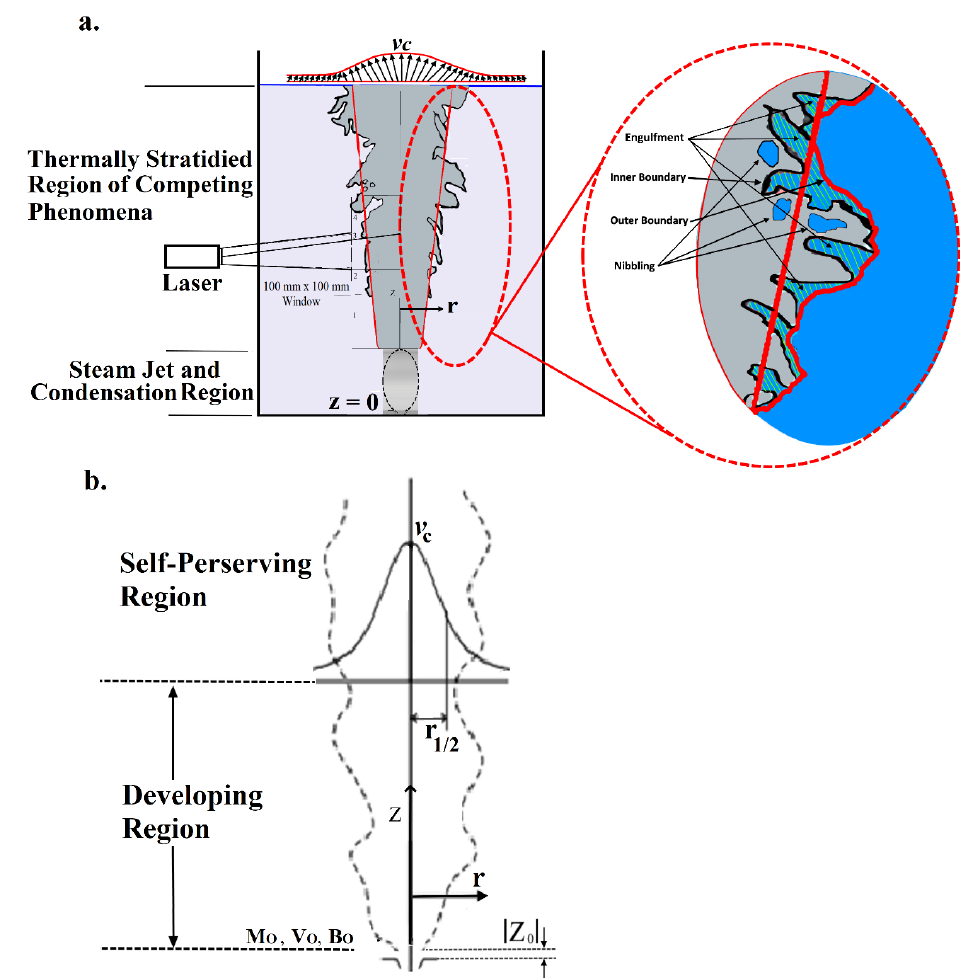
Figure 2. ( a ) A schematic of overall steam jet and its single-phase plume regions; ( b ) a schematic of developing and developed regions of a single-phase liquid heated plume.